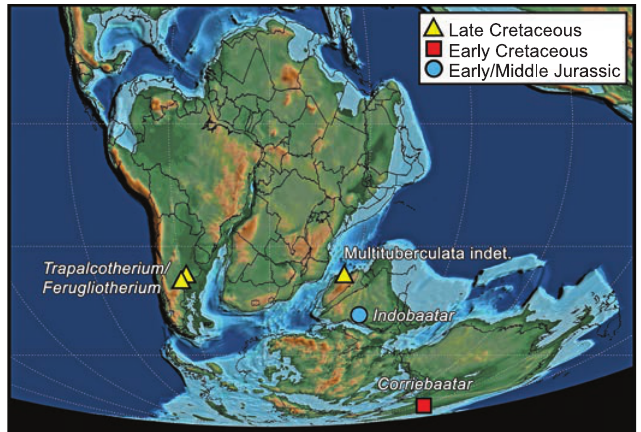
Fig. 7. Known distribution of Mesozoic multituberculates on